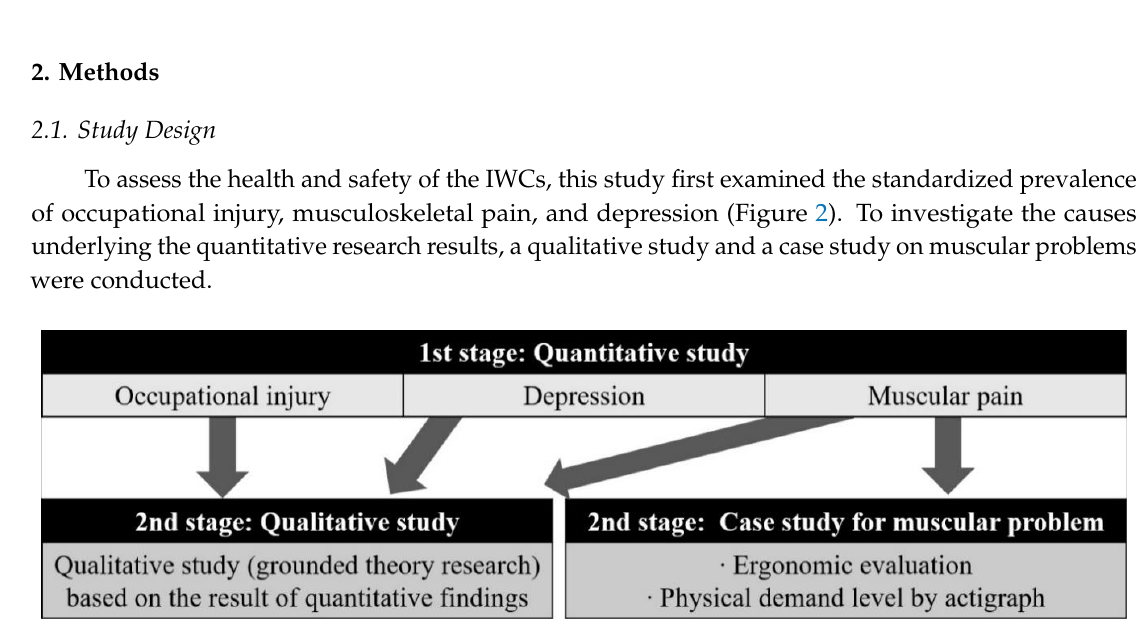
Figure 2. Study model of the health and safety problems amongst informal waste collectors.